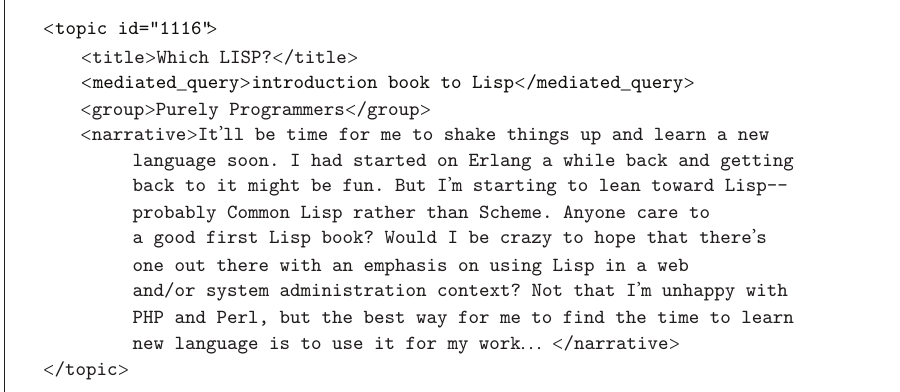
Figure 1: An example of topic from SBS topics set composed with multiple fields to describe user’s